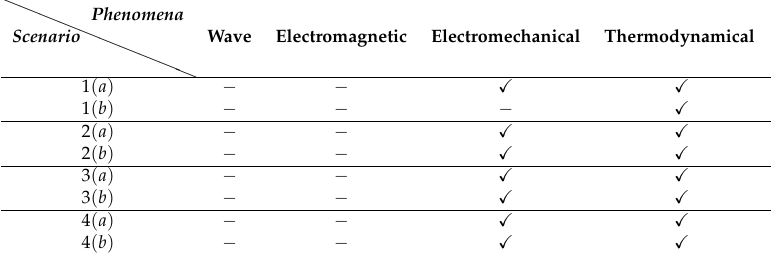
Table 9. Possibility of the usage of each scenario for different power system dynamics.